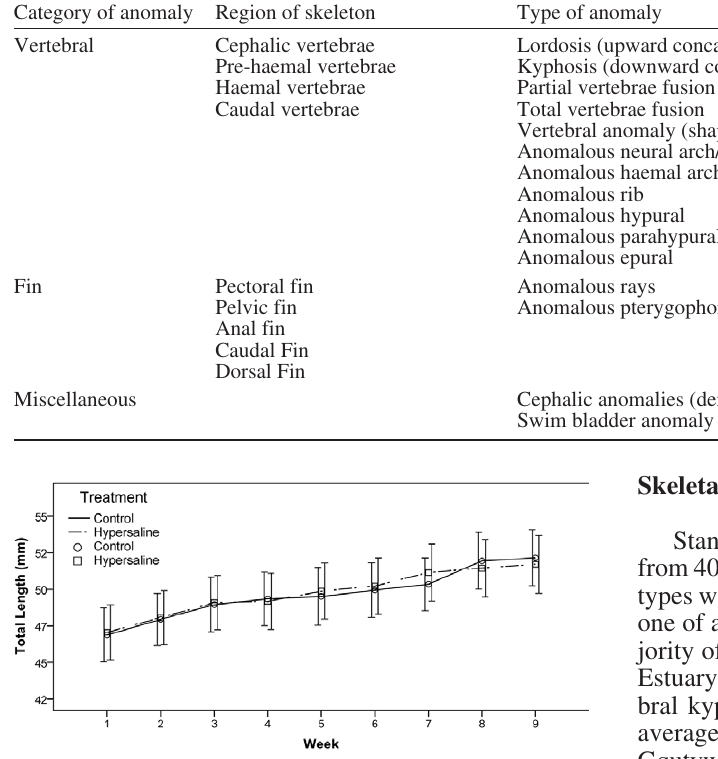
(-)Fig. 1. – Mean total length (mm±SD) of Rhabdosargus holubi ju- veniles grown under control (~30) and hypersaline (~50) treatments for 9